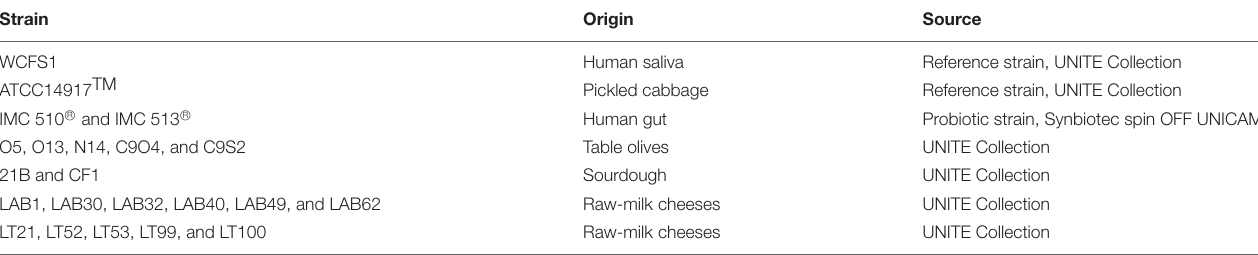
TABLE 1 | Lactobacillus plantarum strains investigated in this